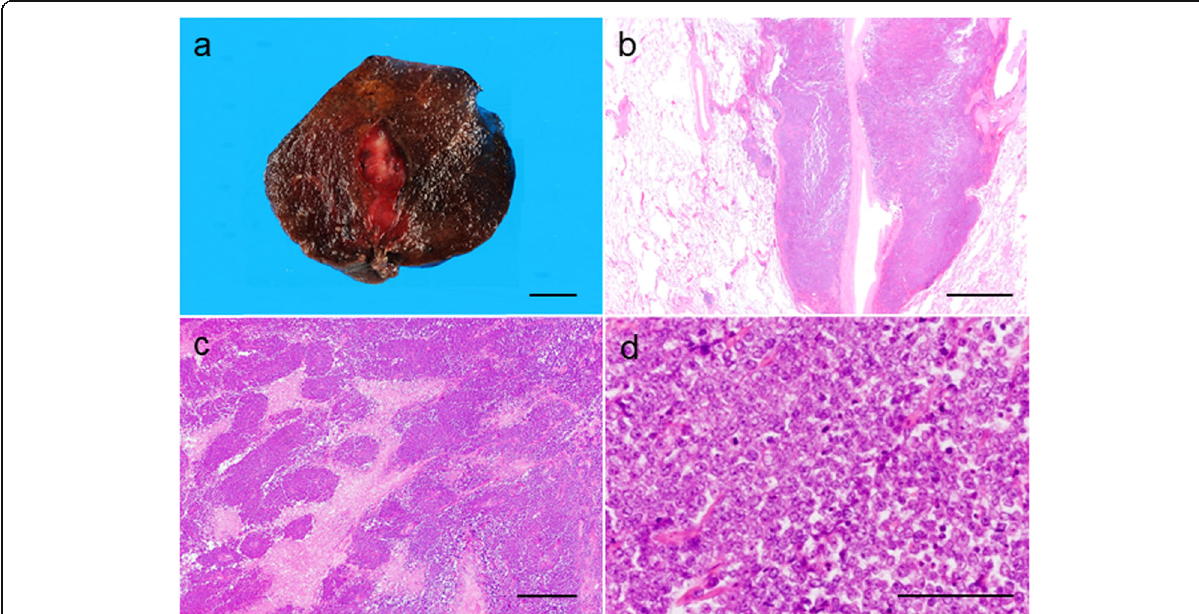
Fig. 2 Gross and histological findings of the pulmonary tumor. a Gross cut section. A white solid tumor with an irregular border and 25 × 12 × 10 mm in size. Bar, 10 mm. b Low-power view showing the tumor mainly in the soft tissue of the bronchial vascular bundle. The structure of the pulmonary artery was maintained inside the tumor. Hematoxylin and eosin (HE) stain. Bar, 2 mm. c Necrosis within the tumor. HE stain. Bar, 500 μ m. d High-power view showing the sheet growth of monomorphic small round cells. Tumor cells had round to oval nuclei with distinct nucleoli and a scanty cytoplasm. Mitotic figures were easily found. HE stain. Bar, 100 μ